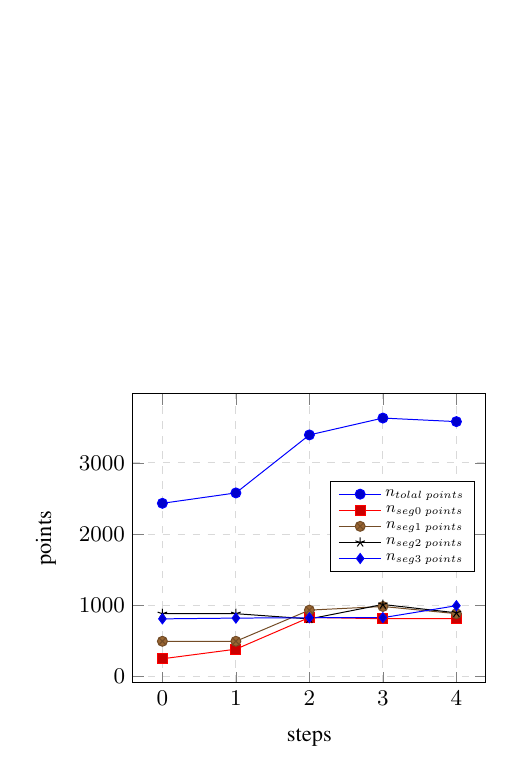
Figure 6. Plot showing the number of points captured at each step when flying the autonomous segment inspection with a radius of 3 m ( 2 m distance to the object surface) with ω = 0 . 25